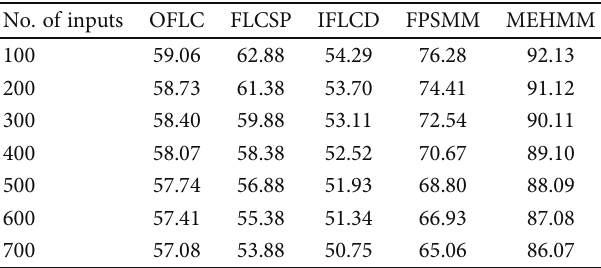
Table 8: Performance of solar